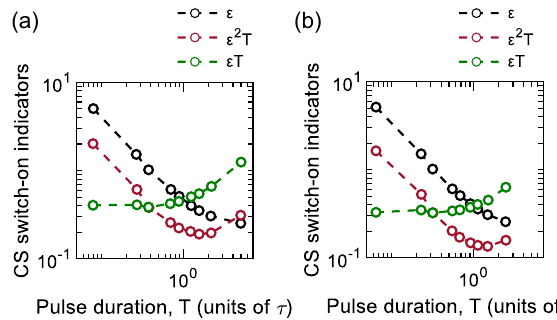
Figure 7: The critical values of a few indicators which correspond to successful cavity soliton (CS) switch-on for (a) Y = 7; (b) Y =